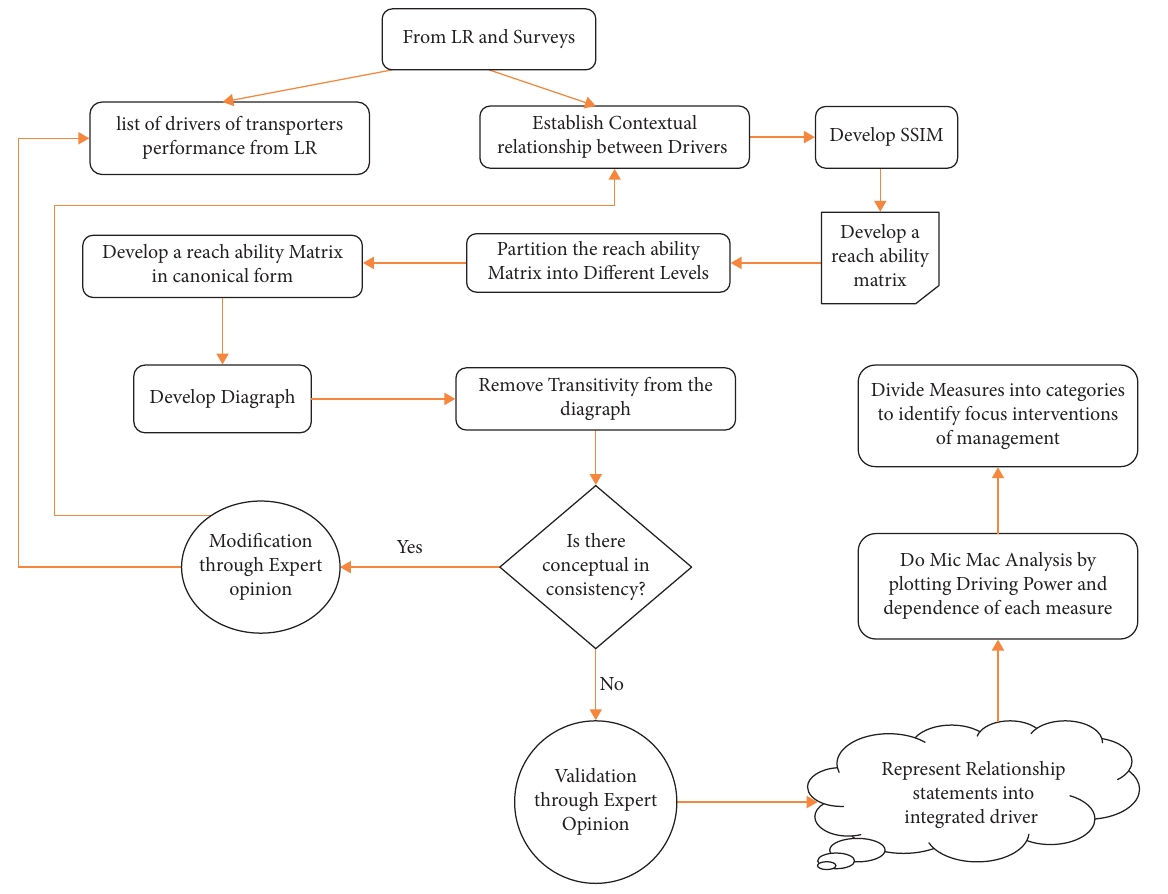
Figure 4: Flowchart for